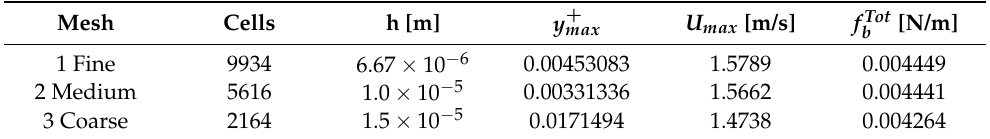
Table 3. Variables for the mesh sensitivity